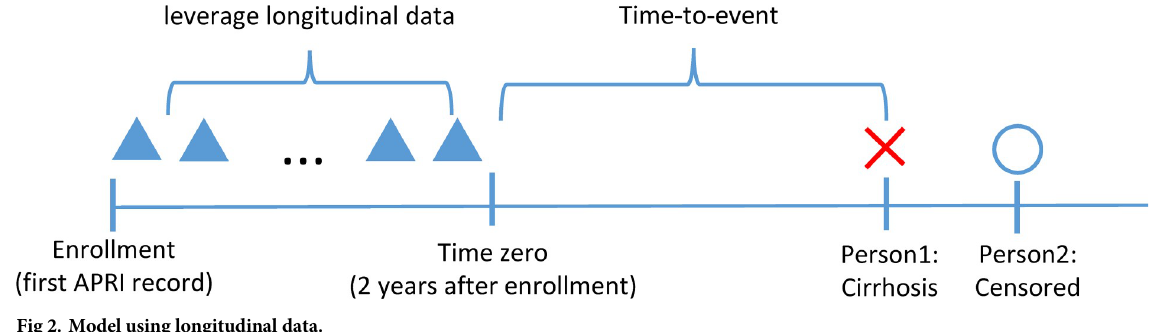
Fig 2. Model using longitudinal